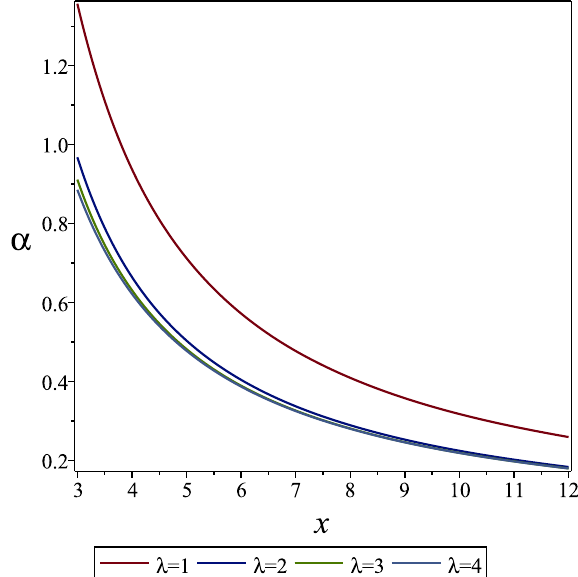
Fig. 2 The plot depicts deflection angle as a function of x = r 0 / 2 M , for the values of M = 1 and S = − 0 . 8. In this case with the increase of λ the deflection angle